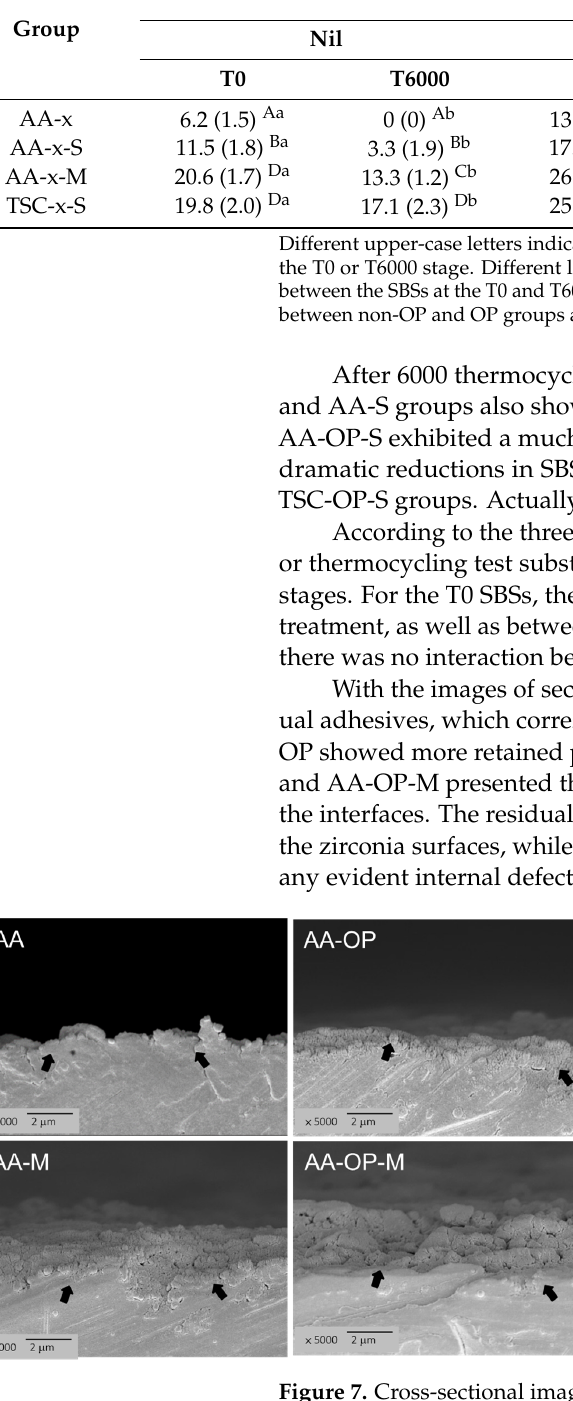
Figure 7. Cross-sectional images of debonded TC6000 zirconia specimens.